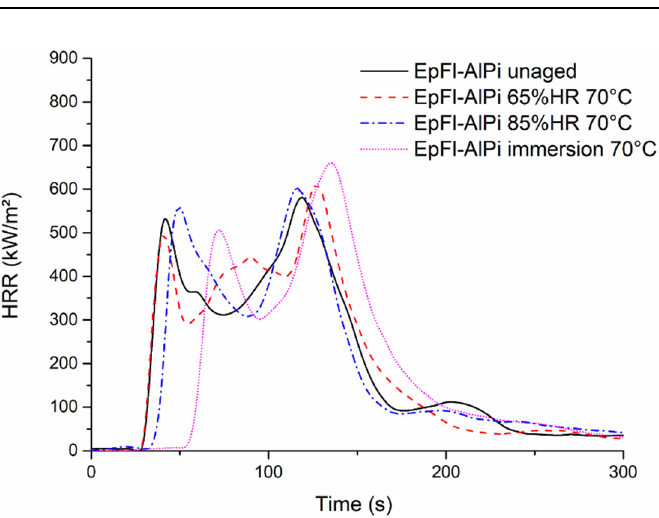
Figure 13. Cone calorimeter curves of EpFl-AlPi aged at 70 °C in different conditions.